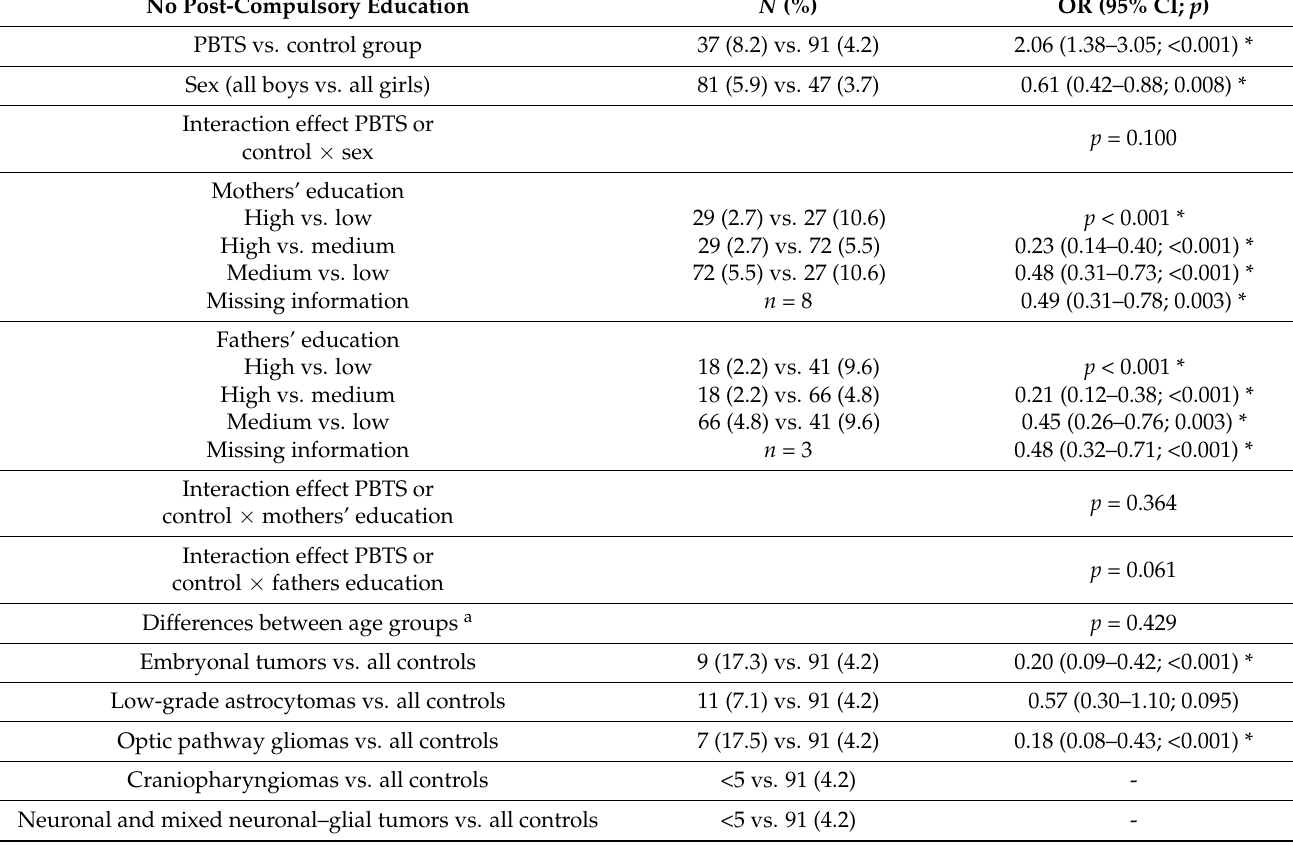
Table 2. No post-compulsory education any time between 2006–2017 for pediatric brain tumor survivors (PBTS; n = 452) and controls ( n = 2188). Statistically significant results are marked with